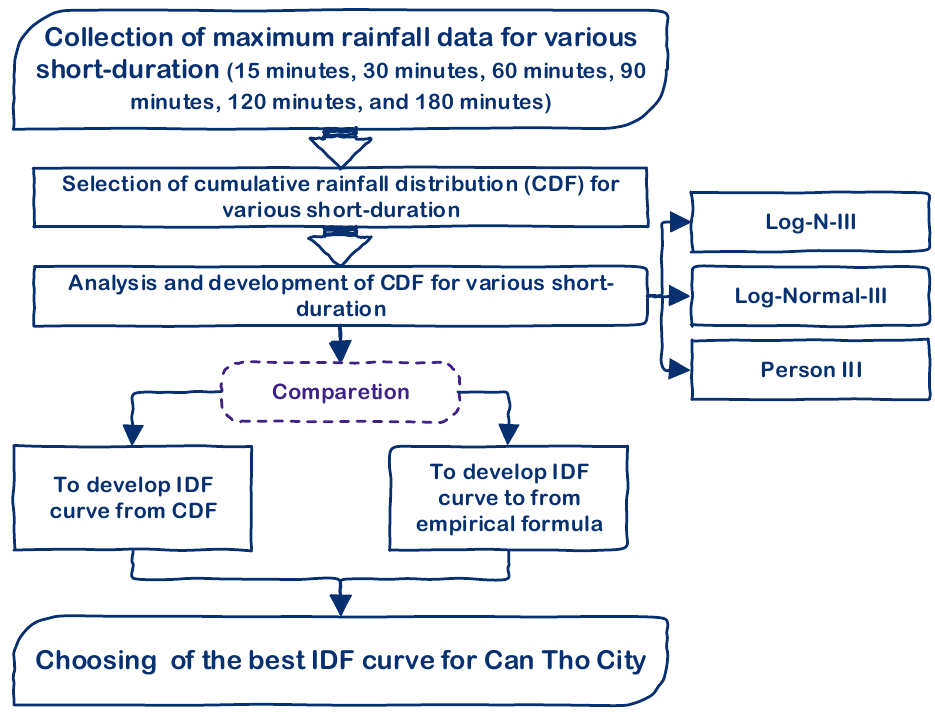
Figure 2. The employed research